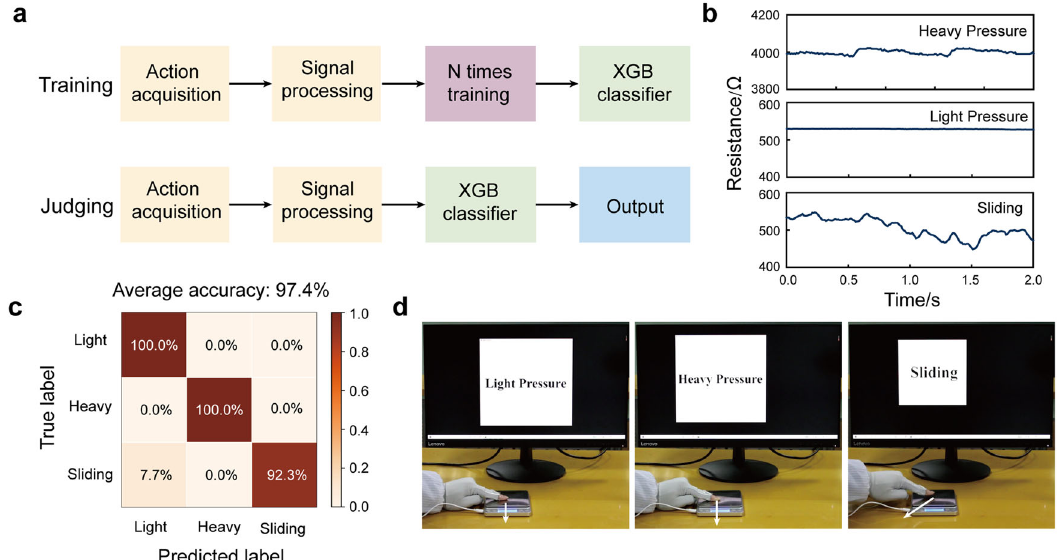
Fig. 3 Demonstration of the multifunction tactile system for the discrimination of light, heavy pressure and slippage. a Machine-learning- assisted data process fl ow, including a training process and an actual judging process. b A set of typical signals of the bioinspired sensor equipped on the human fi nger corresponding to light, heavy pressure and slippage. c Confusion matrix of classi fi cation test derived from the model made by XGBoost. Predicted label refers to the recognized results, and true label refers to the true status. The color bar represents the normalized accuracy. d Photographs of the actual online judging demonstration of human hand integrated with the bioinspired sensor for light, heavy pressure and slippage recognition. The recognition results were shown in the screen. The arrows represent the direction of applied